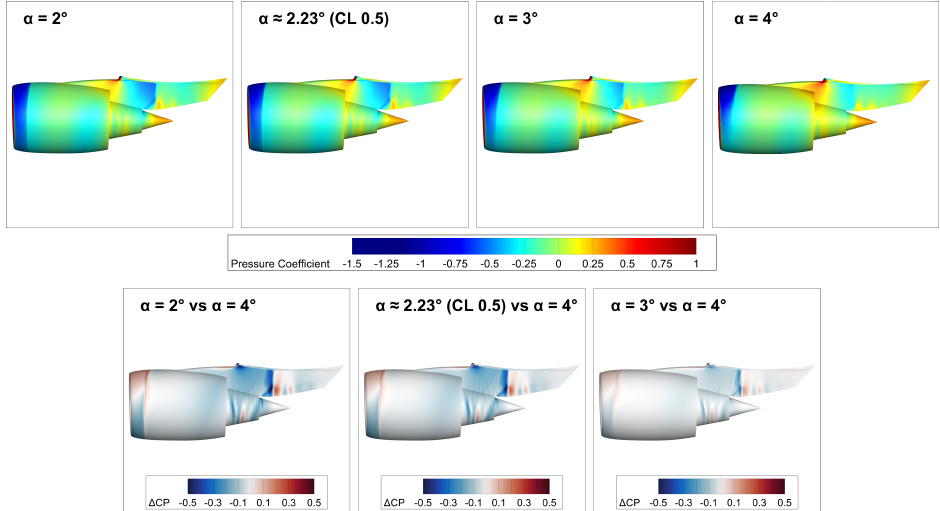
Figure 7. Pressure coefficient distribution on the nacelle and pylon on the inboard side.